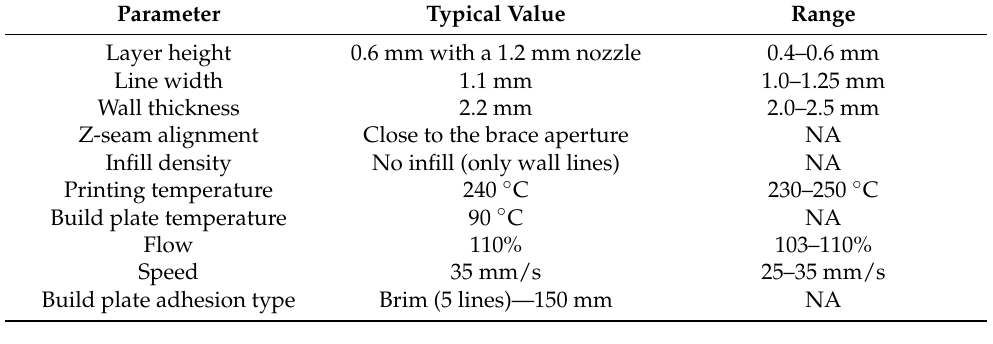
Table 1. Three-dimensional printing parameters. Ranges are provided where applicable. NA: not applicable.